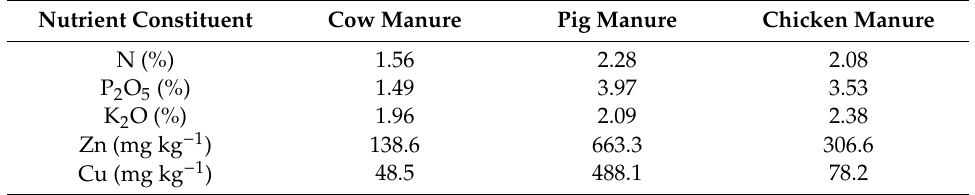
Table 1. The nutrient contents of cow manure, pig manure and chicken manure in China (Source: